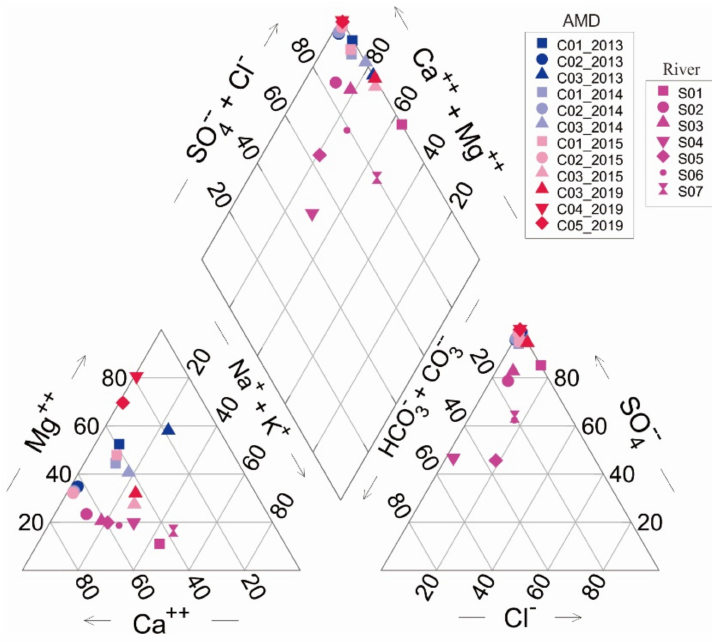
Figure 6. Piper diagram of ionic concentrations in the AMD or river.